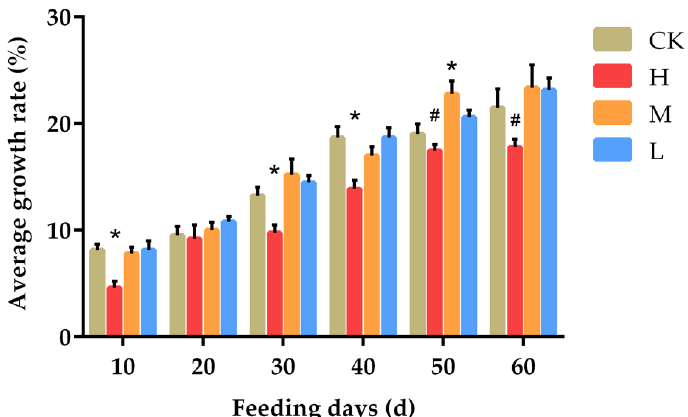
Figure 3. Effects of ALE on body weight growth in mice. Note : CK: 50 μL 0.9% NaCl; H: 50 μL 300 mg/kg ALE; M: 50 μL 150 mg/kg ALE; L: 50 μL 75 mg/kg. * p < 0.05 vs. CK group; # p < 0.05 vs. M group.